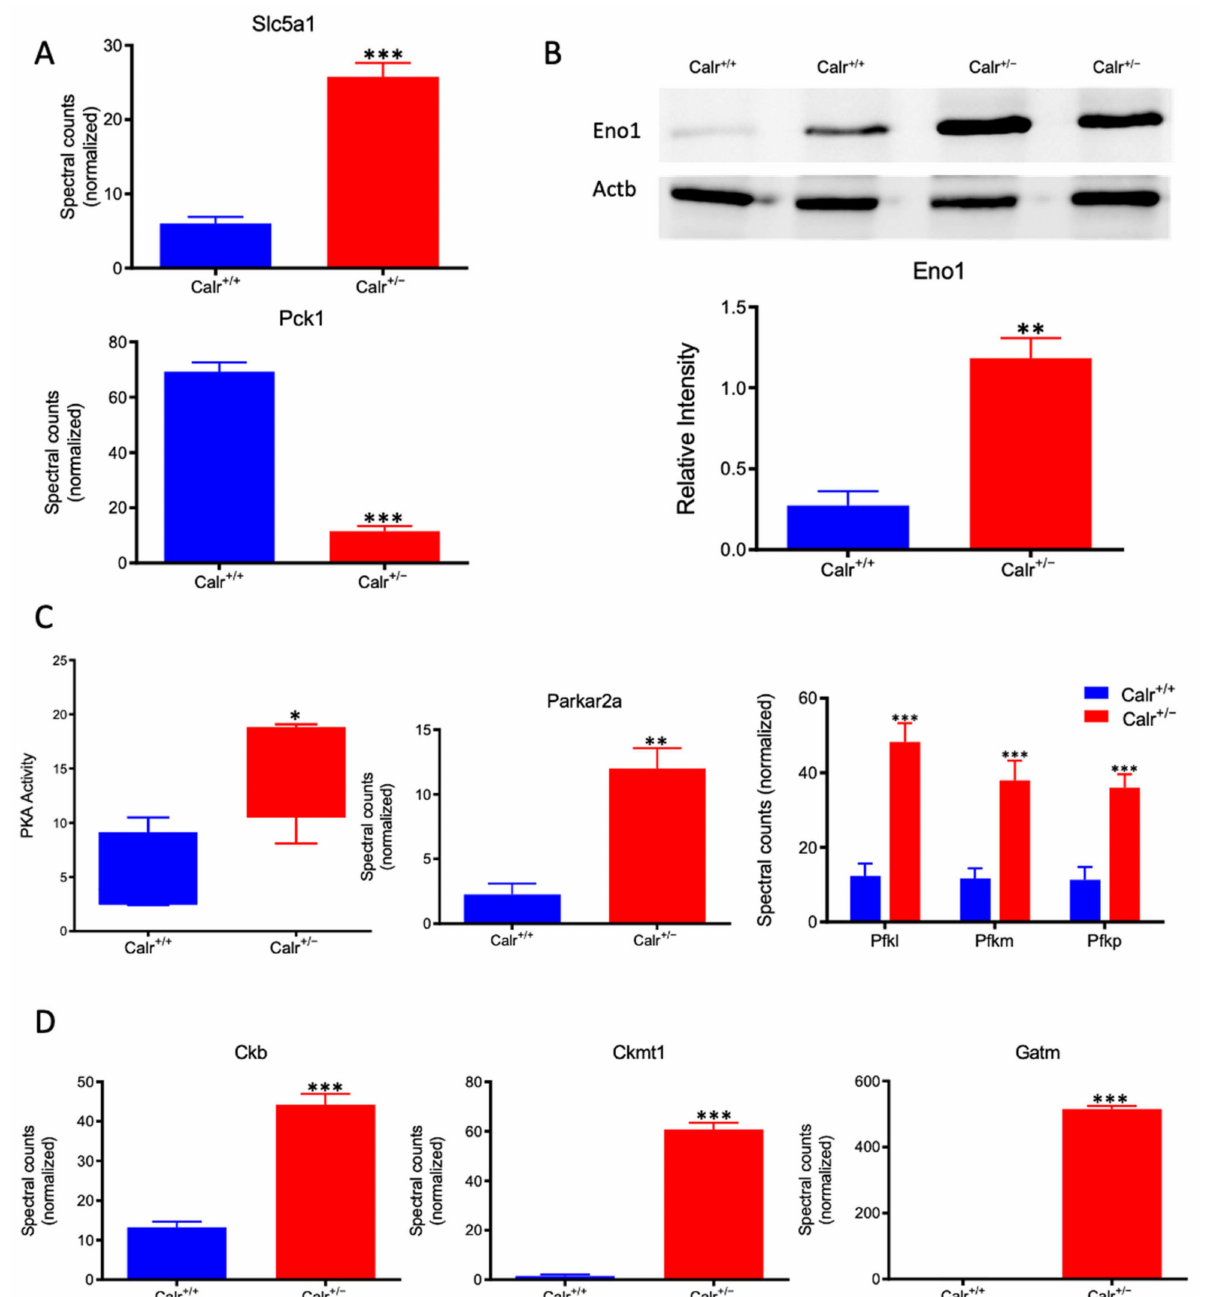
Figure 7. Activation of PKA and glycolysis in Calr +/ − kidney. The intensive mitochondrial damage results in an energy shortage. To overcome the energy crisis, the kidney cells in Calr +/ − mice activate glycolysis. ( A ): Up-regulation of Slc5a1 a sodium/glucose cotransporter 1, which actively transports glucose into the cell, and PcK1 is also up-regulated to actively augment the glucose synthesis from lactate. ( B ): Enolase 1 is also up-regulated to favor the energy production from glucose. ( C ): PKA is significantly up-regulated and activated to accelerate glycolysis and to promote energy production, and the important glycolysis kinase PFK is significantly up-regulated in Calr +/ − mouse kidneys. ( D ): Parallel to the activation of glycolysis, the enzymes involved in production of the alternative energy from phosphocreatine are also up-regulated in Calr +/ − mouse kidney. data (*: p < 0.05) **: p < 0.01, ***: p <